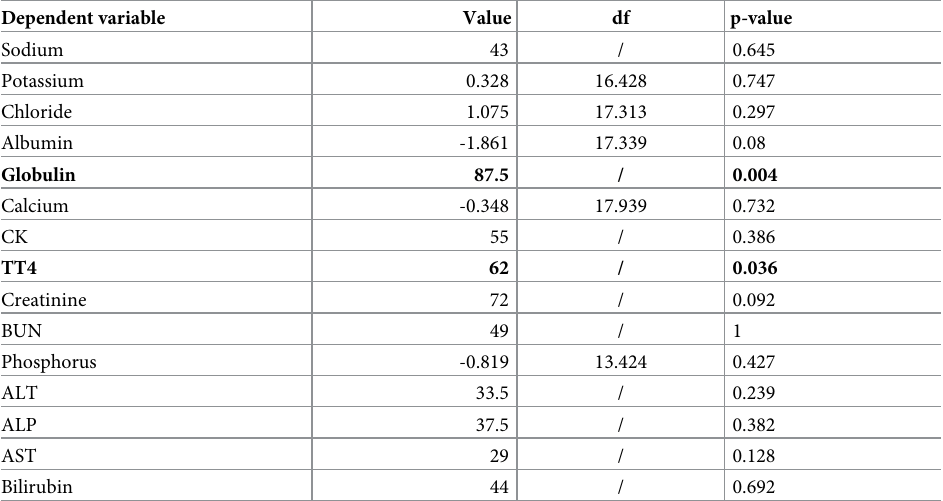
Table 5. Effect of the presence of neoplasia on blood chemistry findings in FeLV positive cats compared to those without